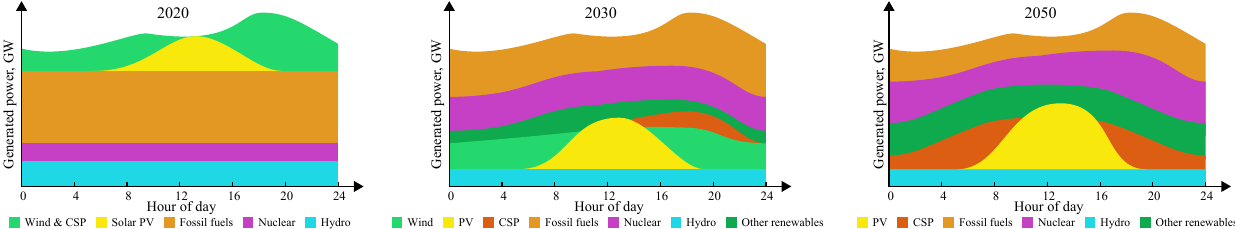
Figure 16. Conceptual daily electricity mix for short term (2030) and long term (2050) supply. Rather than a single dominant generator, all sources will work in harmony to maximize efficiency and mitigate